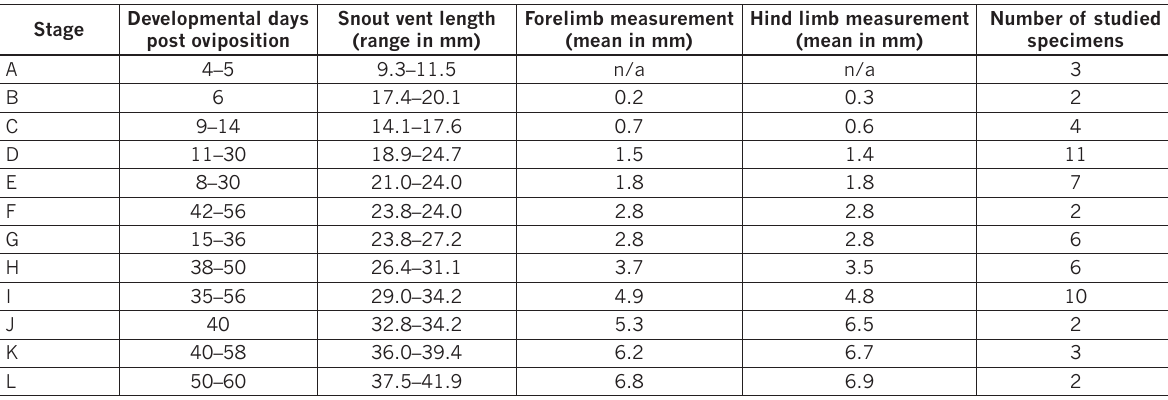
Table 1. Developmental age range and external length measurements of Hemidactylus stages A to L. All embryos were studied to identify key features characteristic for each